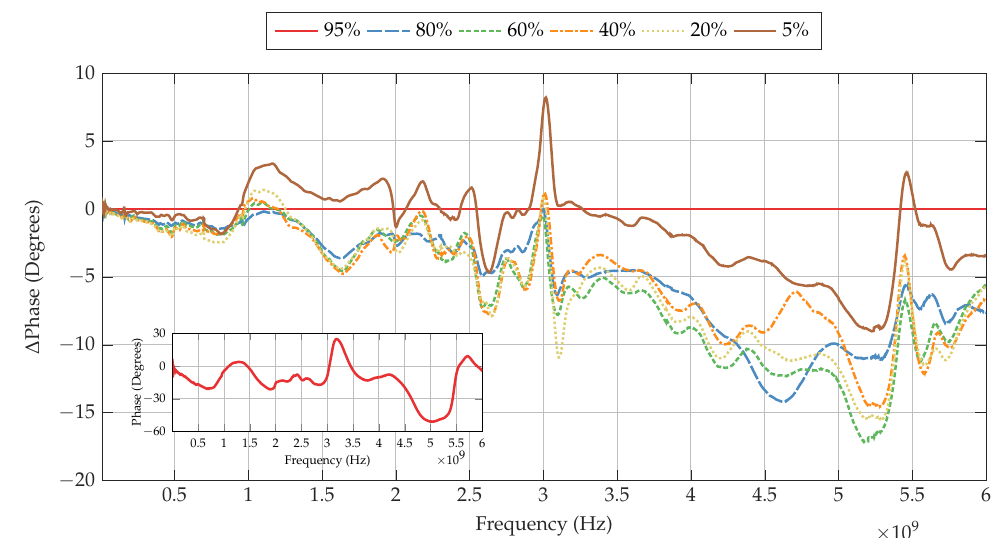
Figure 9. Change in phase of a Li-ion cell at various SoCs, using 95% SoC as a baseline. Inset shows the baseline phase shift of the Li-ion cell at 95% SoC with the background